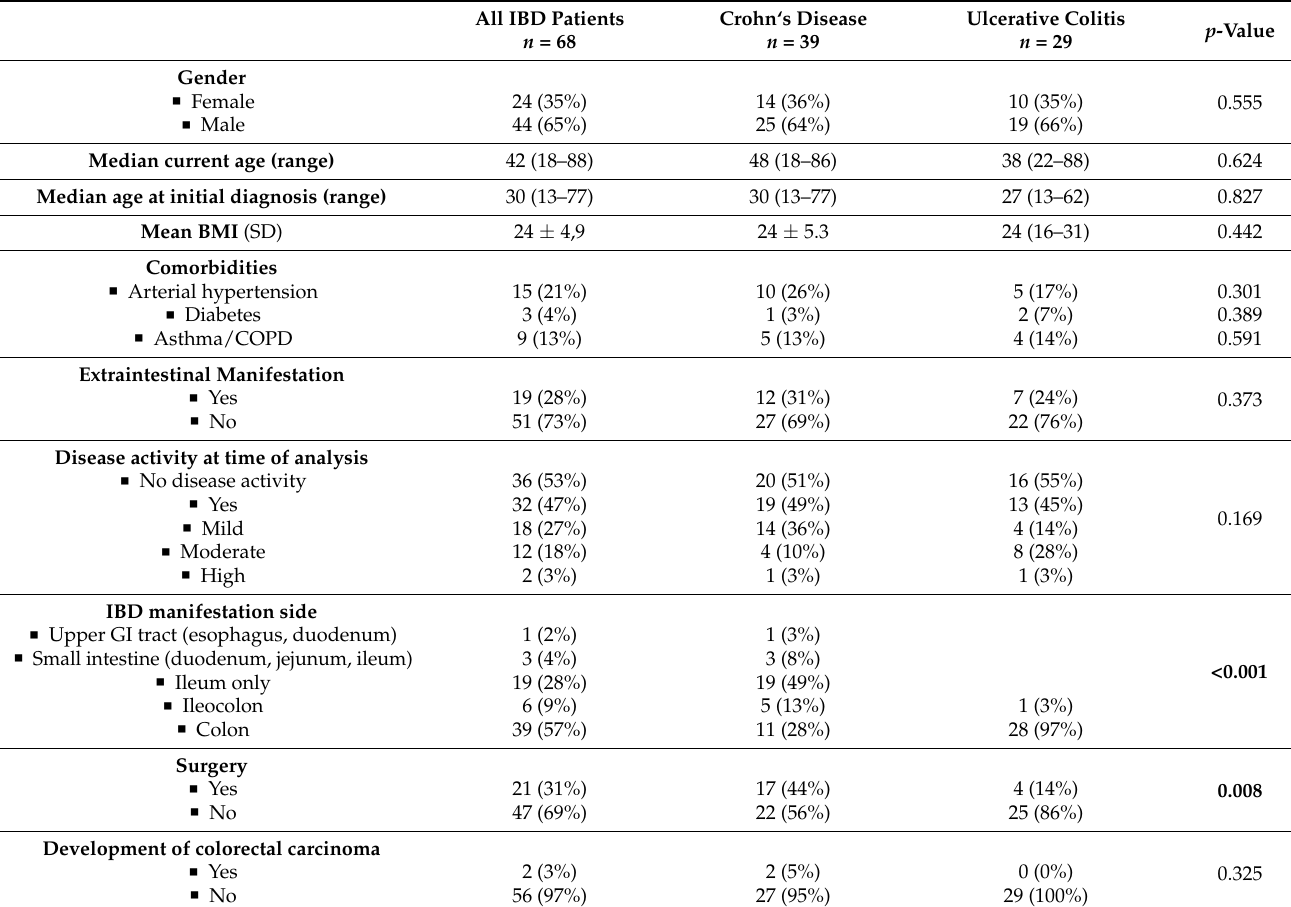
Table 2. Baseline patient and disease characteristics of the IBD cohort. All IBD Patients n =